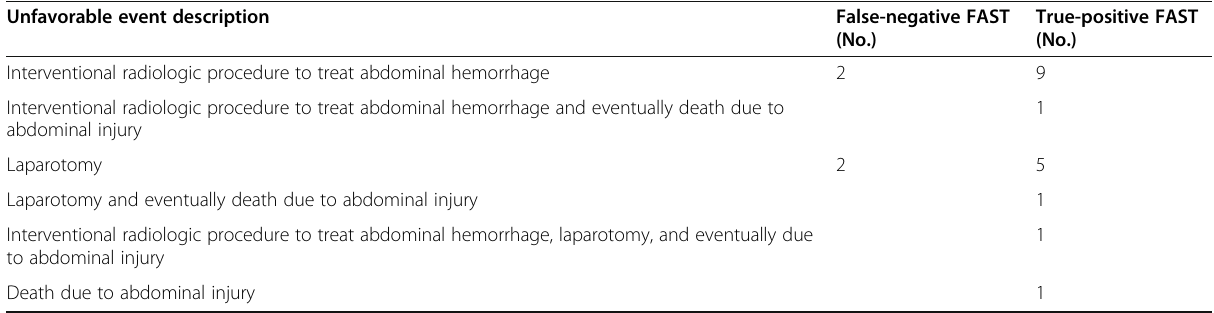
Table 3 FAST results in the 22 patients with an unfavorable outcome Unfavorable event